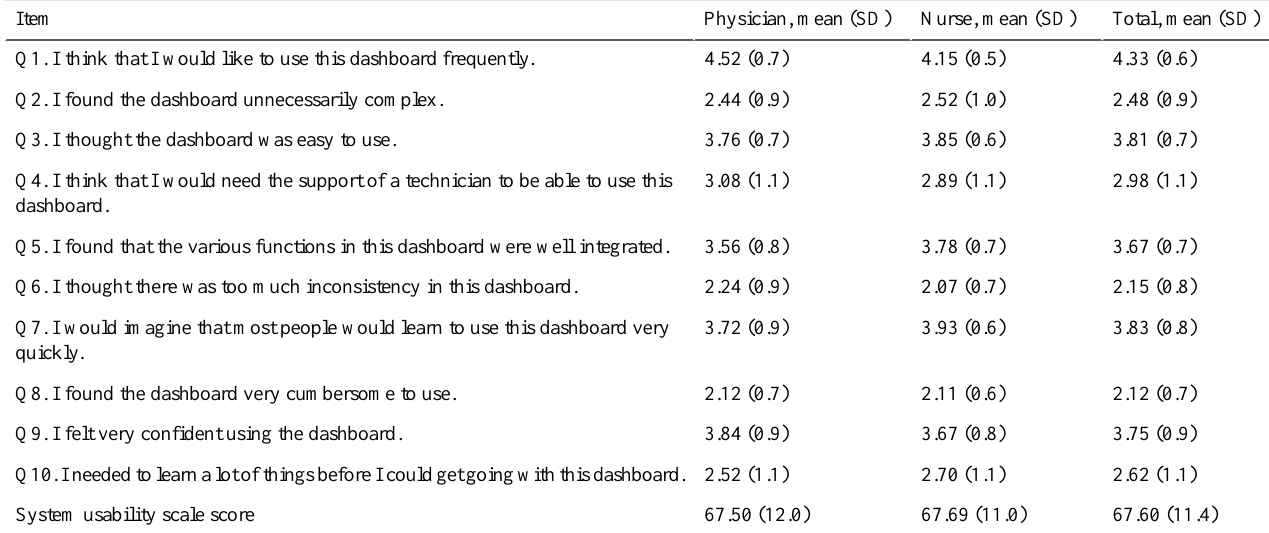
Table 2. System usability scale